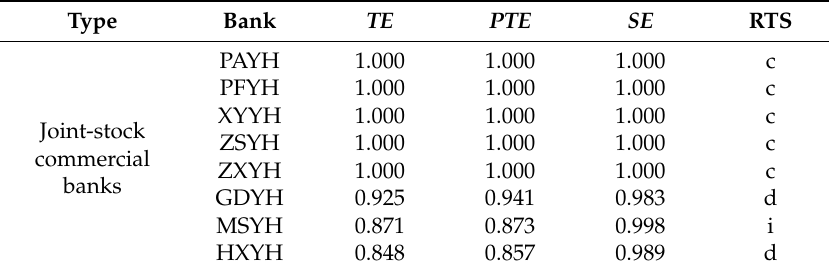
Table 6. The efficiency evaluation of the joint-stock commercial banks in 2017.